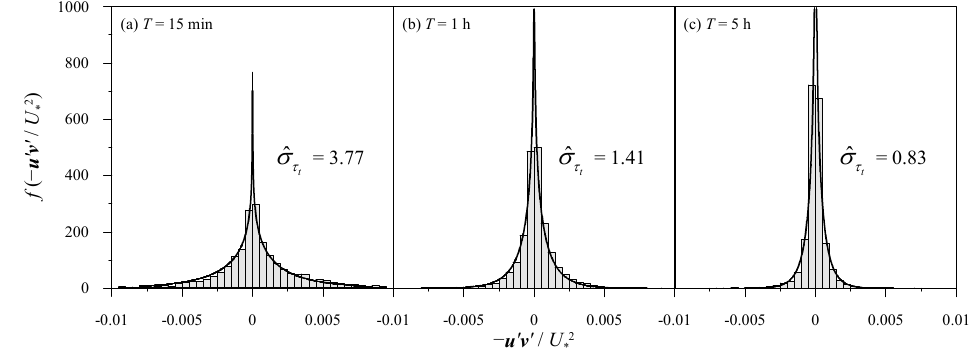
Figure 10. Comparisons of the measured probability distributions of − u (cid:48) v (cid:48) / U ∗ 2 and fitted theoretical distributions (Equation (5)) for Run S-2: ( a ) T = 15 minutes, ( b ) T = 1 h, and ( c ) T = 5 h. Table 3 summarizes the temporal variations in the mean (